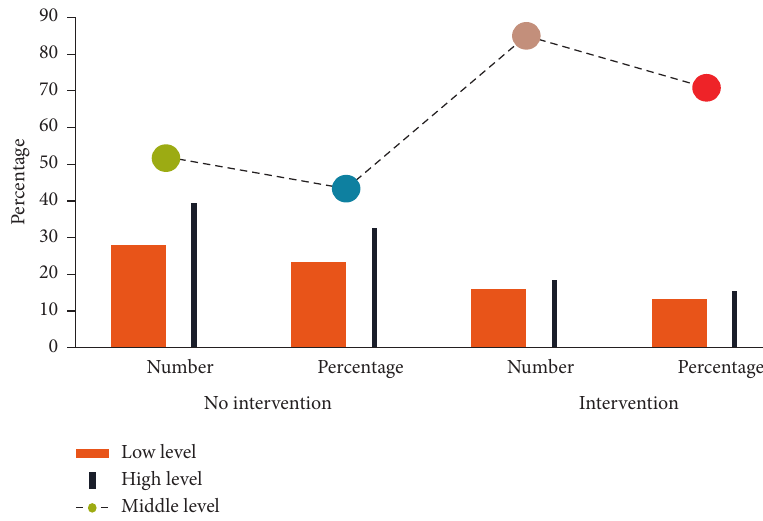
Figure 6: Percentage of people with no intervention and reflection level with intervention.